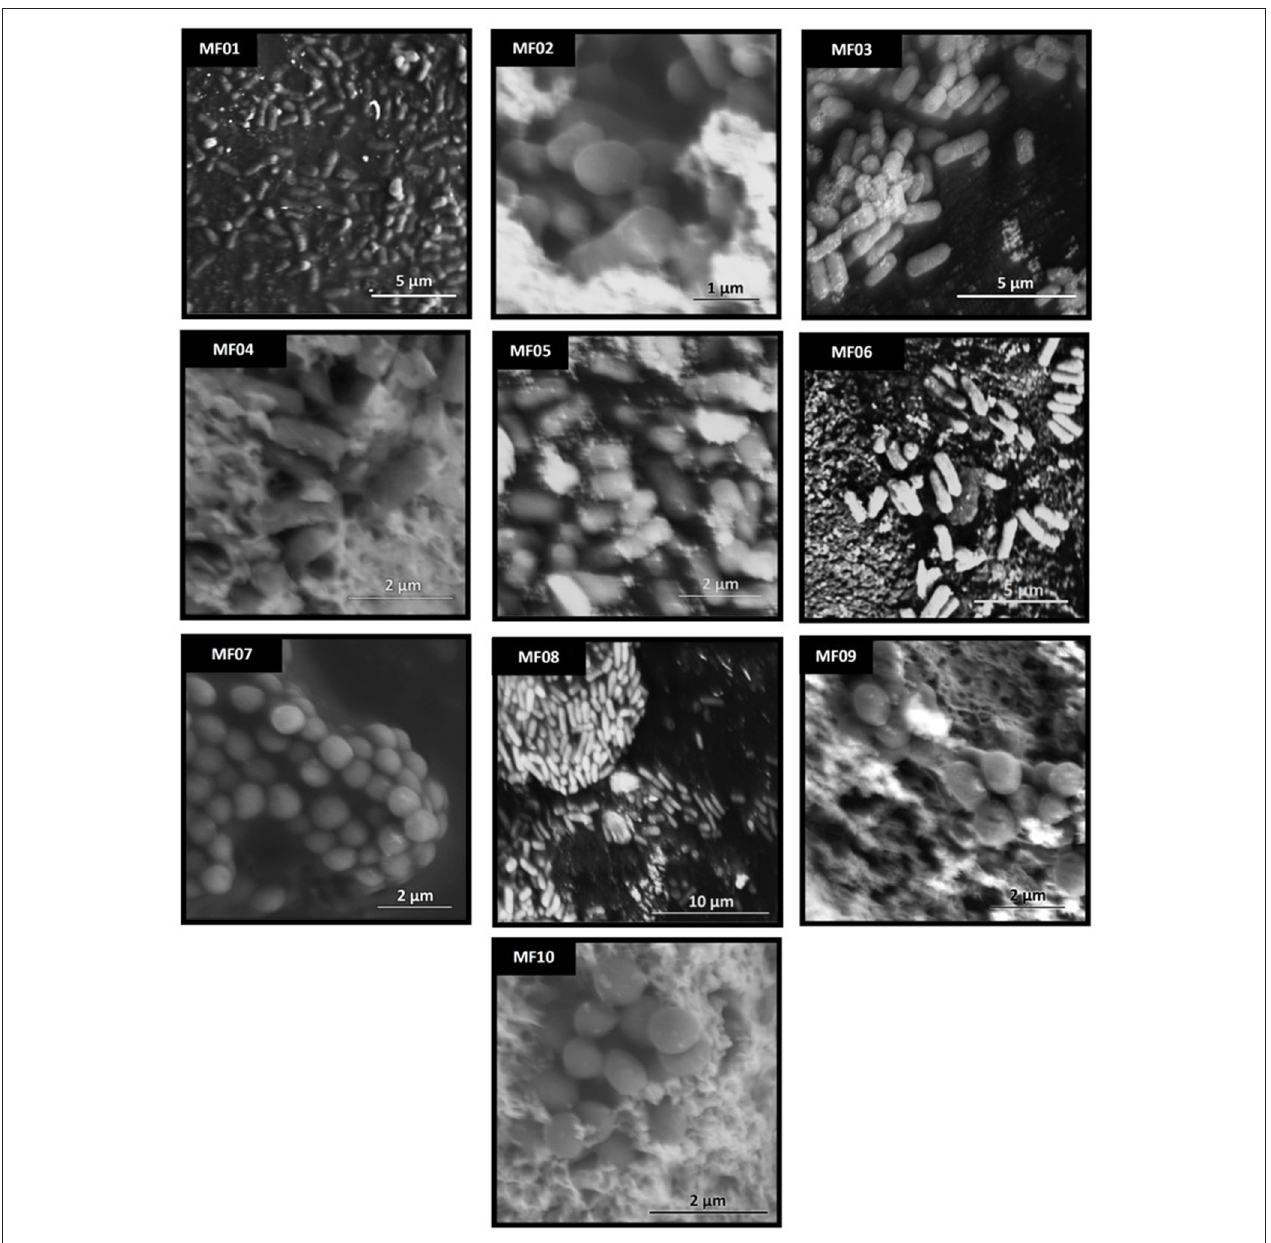
FIGURE 1 | Scanning electron microscopy of the environmental multi-metal(loid) resistant bacterial strains. Cells were prepared for SEM as described in Methods. Each image represents a different strain (indicated in the black